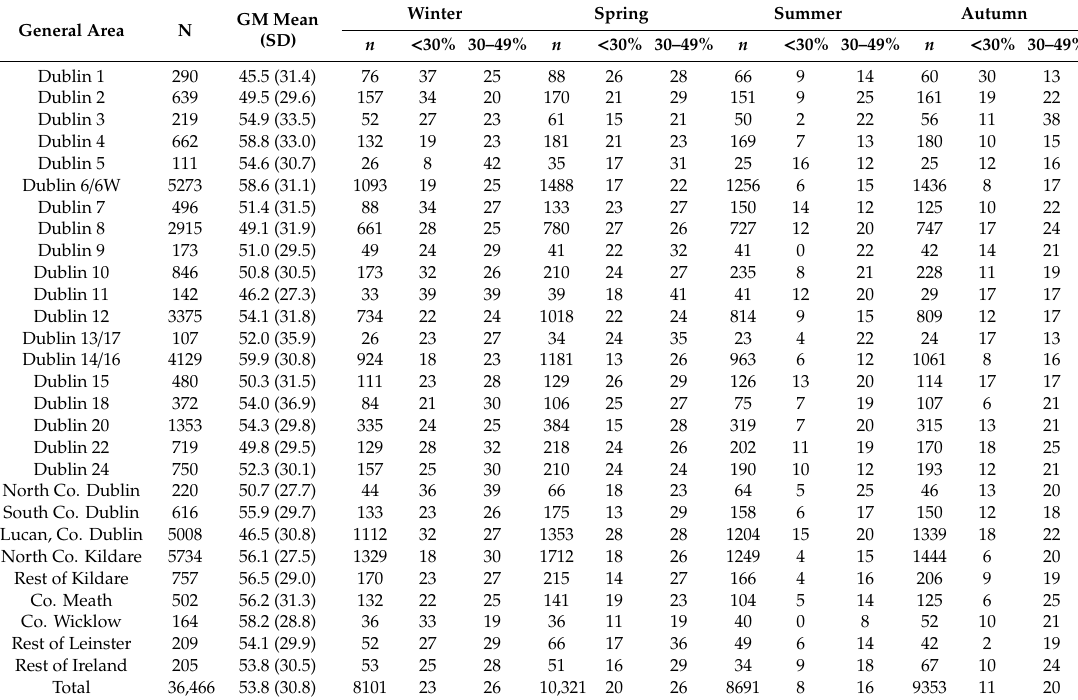
Table 4. 25(OH)D status by area and